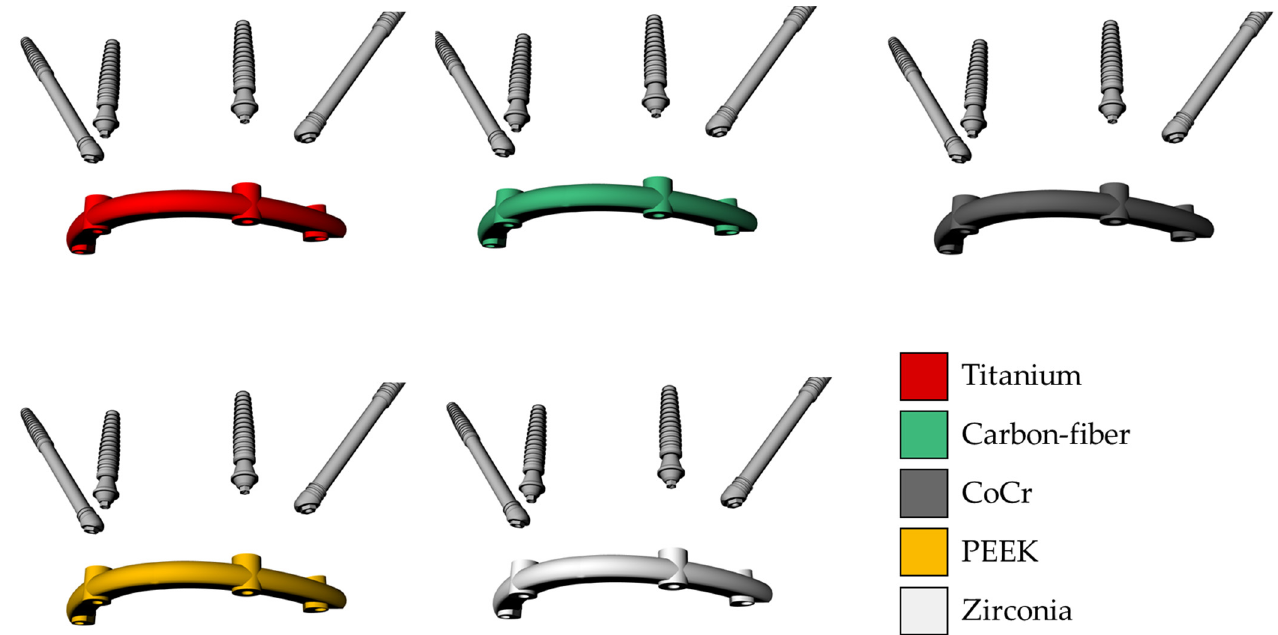
Figure 3. Schematic illustration of each simulated material for the superstructure in contact with the implants. Different colors represent different elastic moduli.